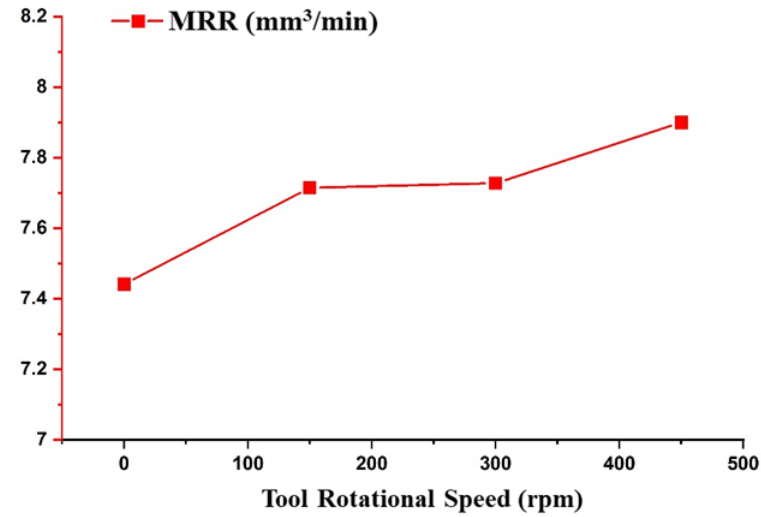
Figure 7. Effect of the Tool Rotational Speed on the Responses.